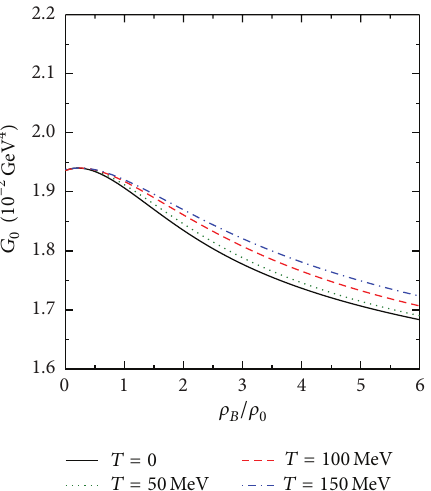
Figure 2: (Color online) The scalar gluon condensate 𝐺 0 plotted as a function of density of the nuclear medium, in units of nuclear saturation density, for different values of temperatures ( 𝑇 = 0, 50, 100 , and 150 MeV).